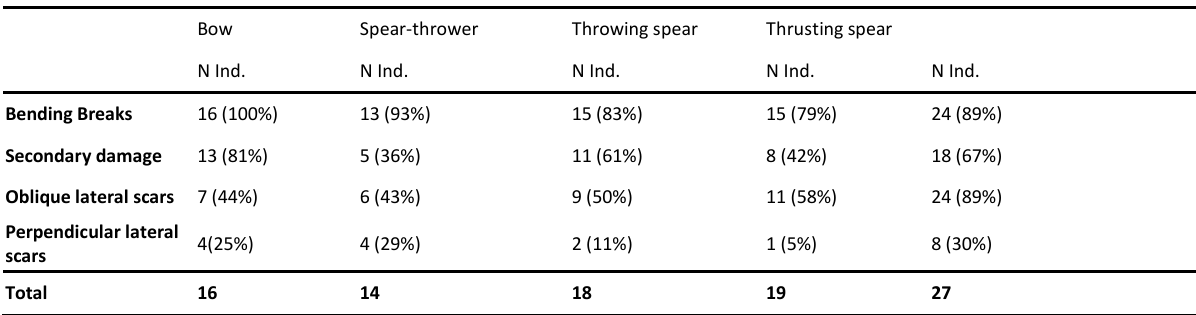
Table 15 . Comparison of the number of piece affected by at least one fracture category between the Traceolab reference collection (gravette and microgravette) organized by mode of propulsion and the Lommel-Maatheide identified projectile